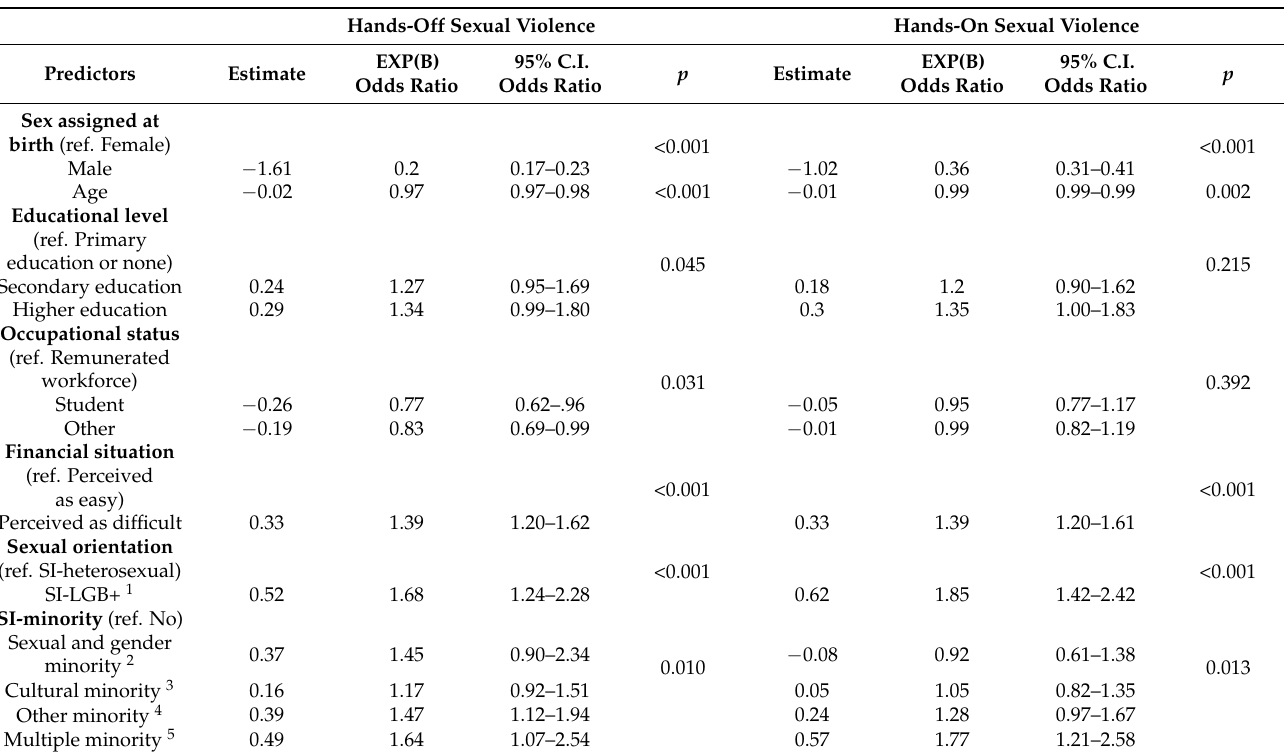
Table 6. Logistic regression analyses for two outcome variables: Lifetime prevalence of hands-off sexual violence and hands-on sexual violence. Hands-Off Sexual Violence Hands-On Sexual